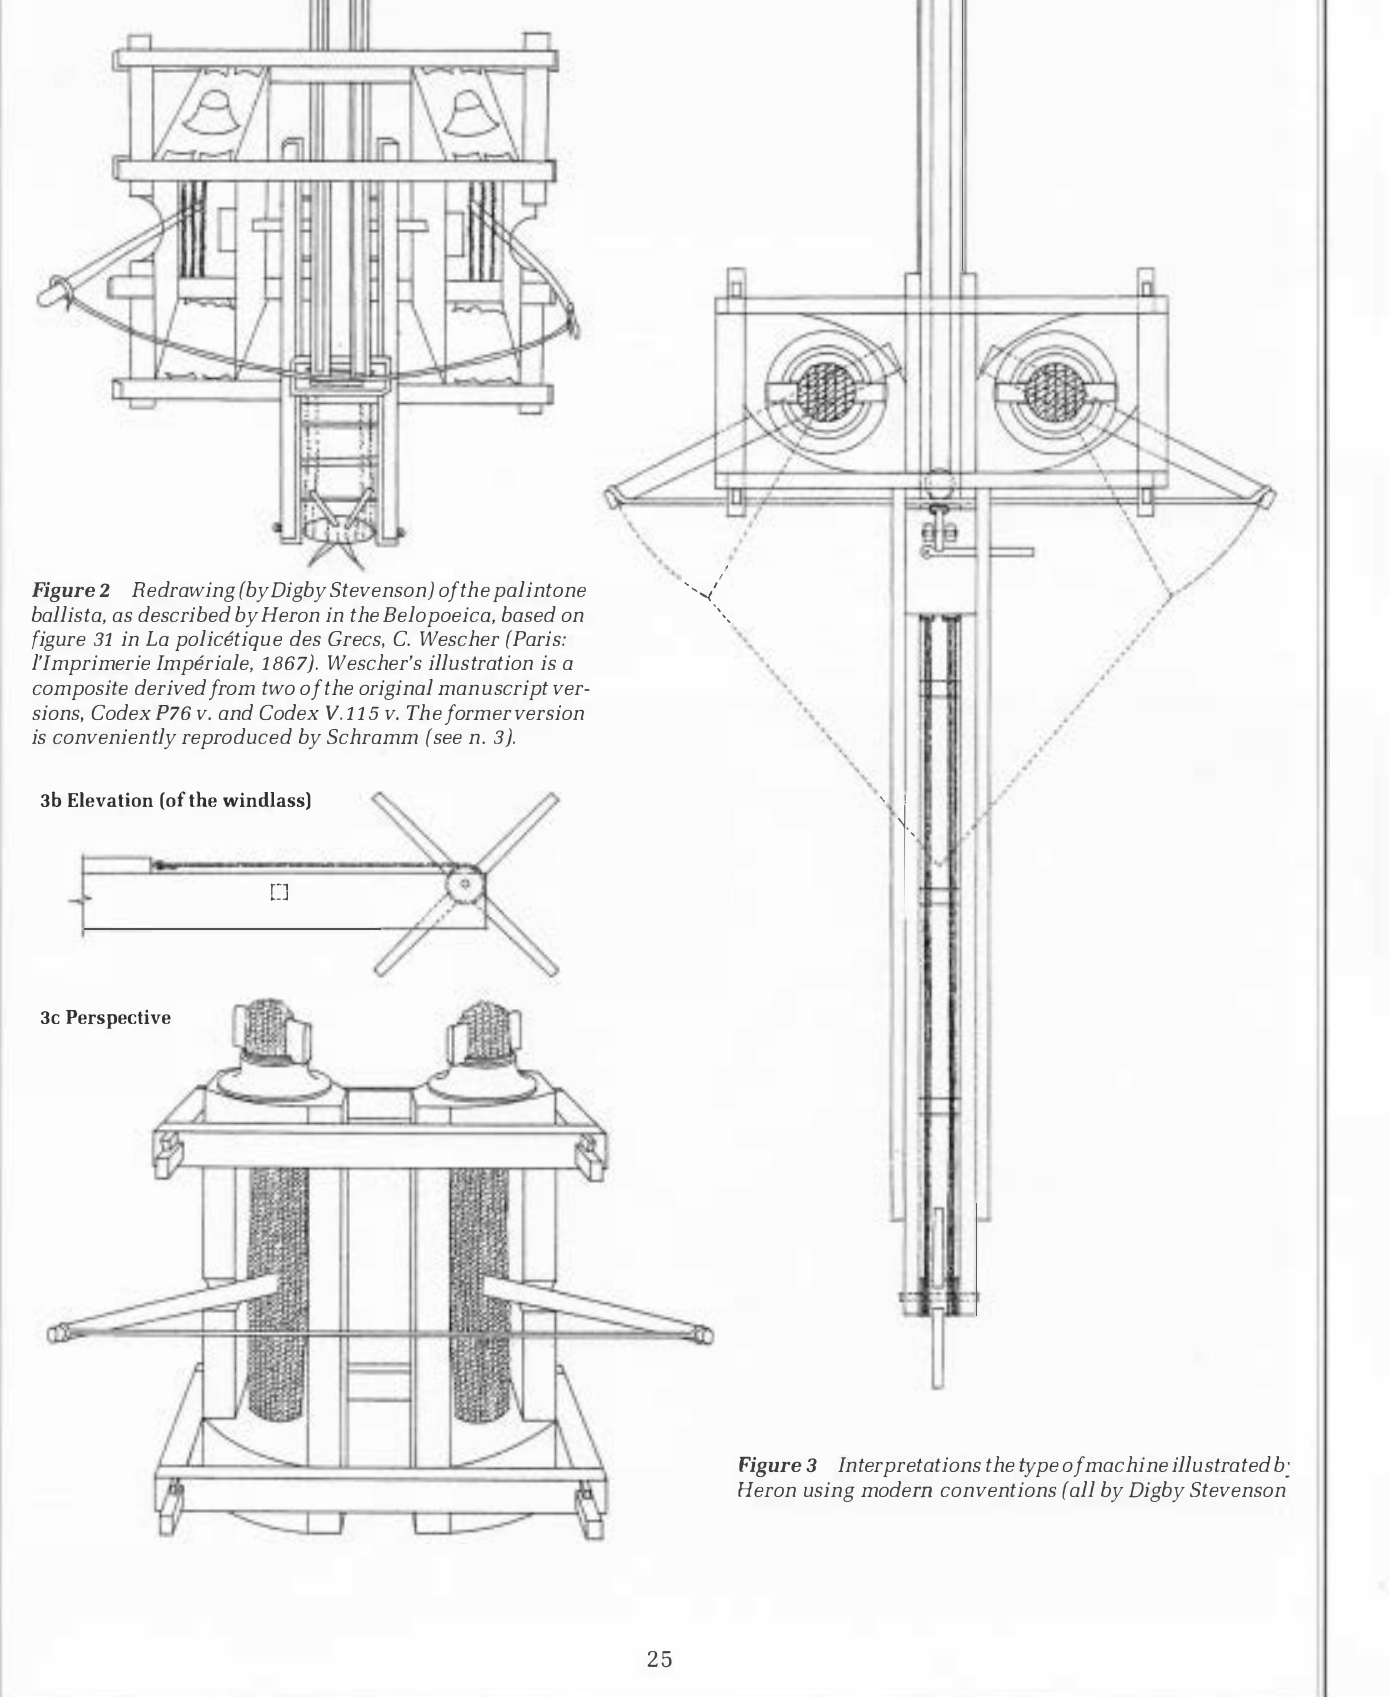
Figure 3 Interpretations the type of machine illustrated b: Heron using modern conventions (all by Digby